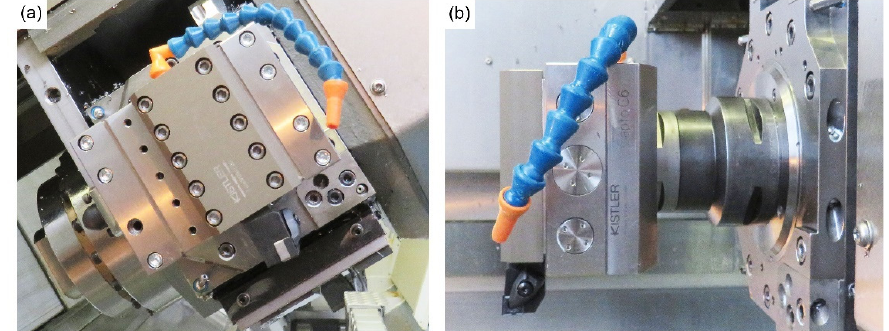
Figure 2. Photographs of the ( a ) front and ( b ) side of the Kistler 9129AA dynamometer plate installed in the WFL M100 MillTurn machining centre with the tool holder and insert in place prior to the machining operation.